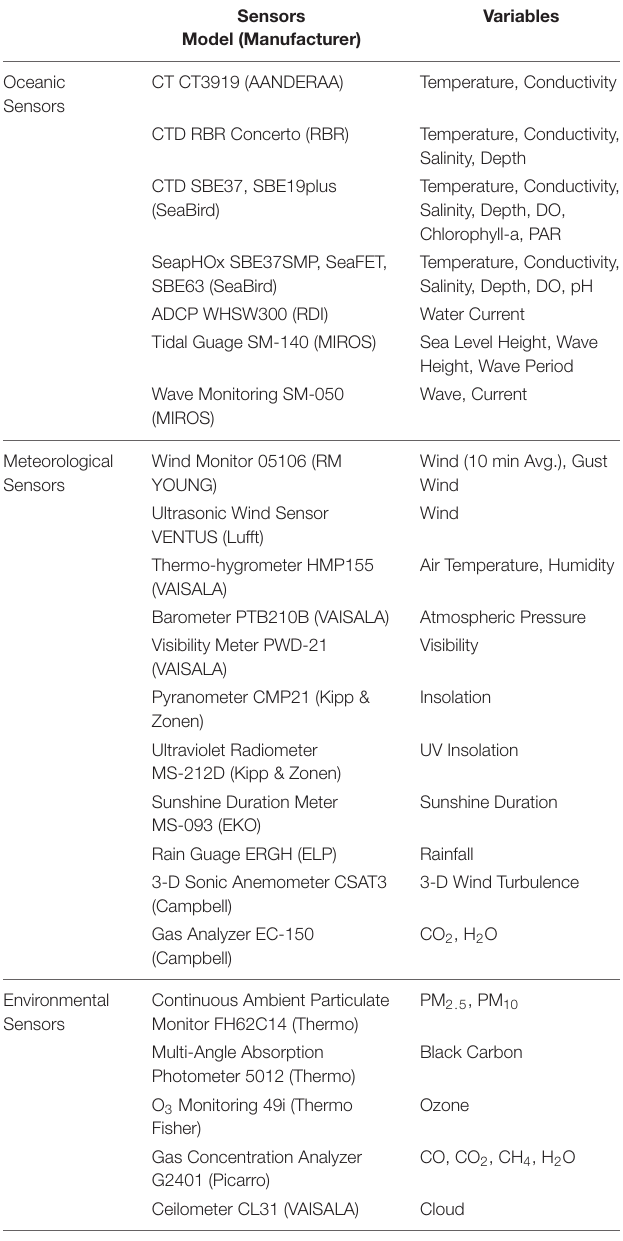
TABLE 1 | List of the major observation sensors and variables of the S-ORS. Sensors Variables Model